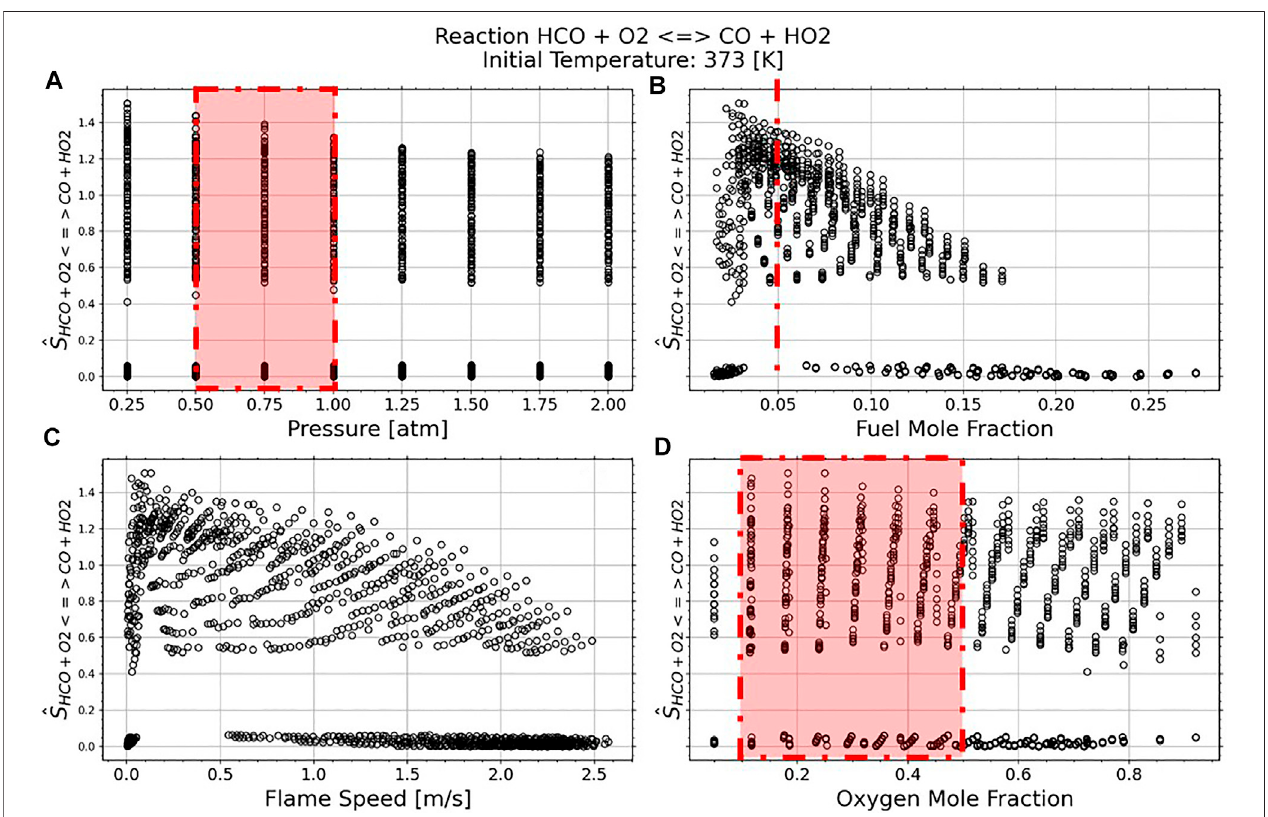
FIGURE 7 | Reaction 31 HCO + O2 ↔ CO + HO2 Normalized Sensitivity Strength against the top seven reactions per case. The red dashed lines indicate experimental conditions from Santner et al. (2015).